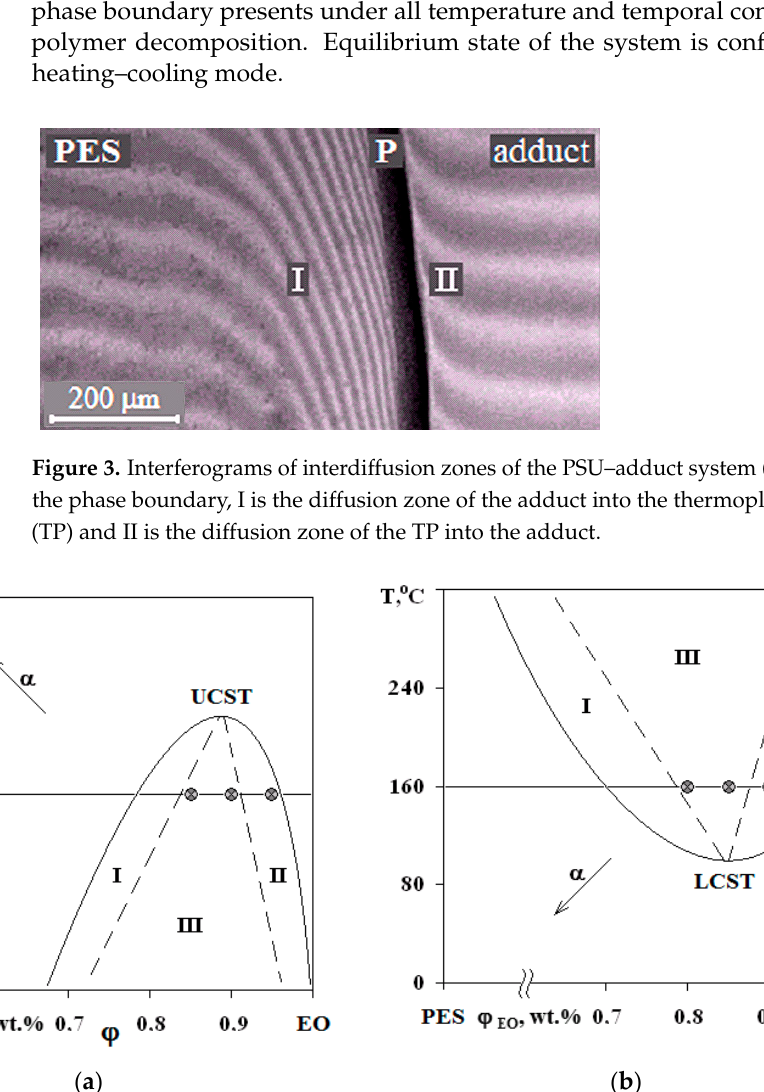
Figure 4. PDs of EO mixtures with PSU at α = 0.25 ( a ) and with PES at α = 0 ( b ). Regions I and II—structures of the “matrix-inclusion” type (sea-island); III—phase reversal region. The compositions of studied systems are marked on the isotherm at 160 ° С .